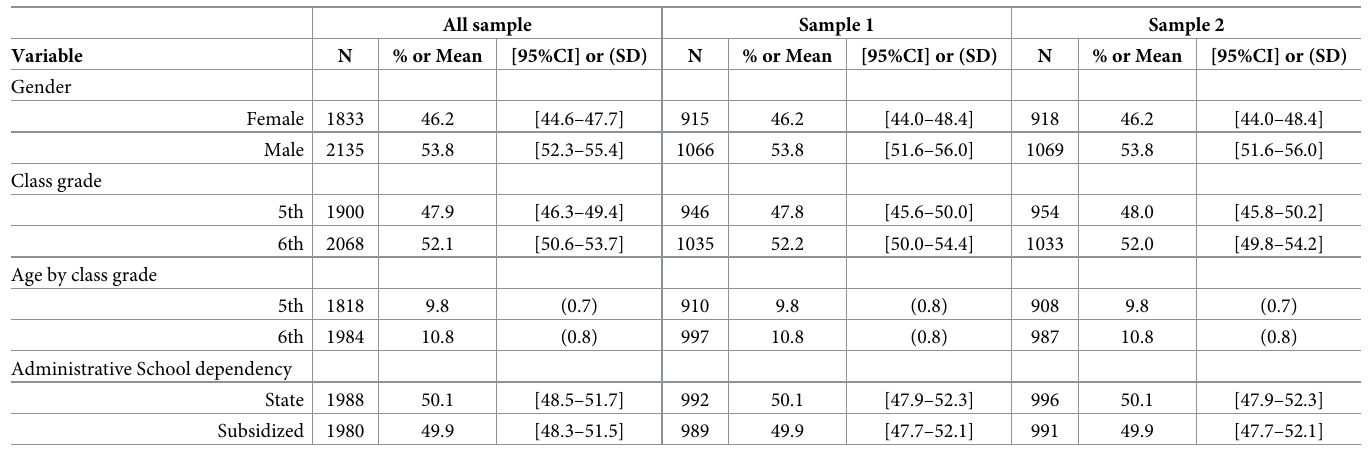
Table 1. Descriptive variables: Gender, class grade, age, and type of school.